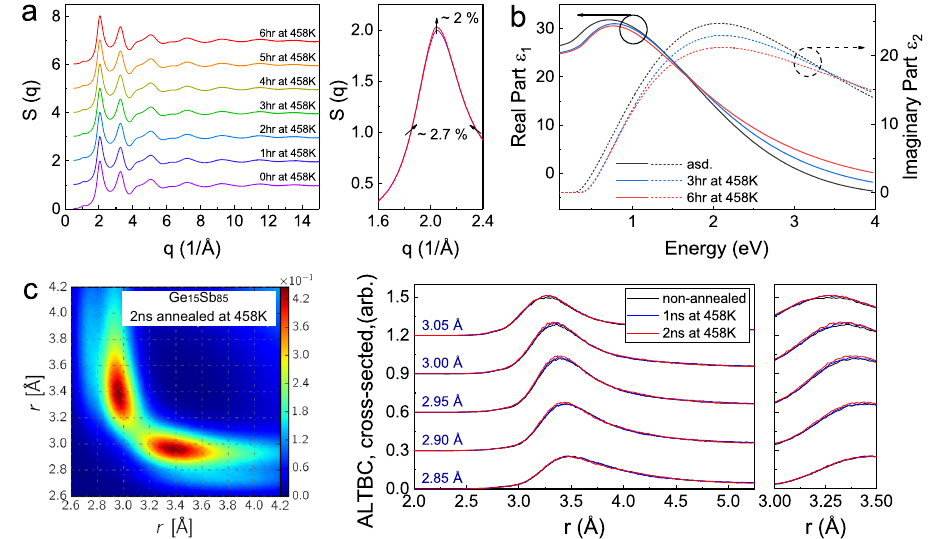
Fig.4|Thestructuralandbondingchangesduringtheisothermalannealingof the amorphous Ge 15 Sb 85 at ~458K. a The S(q) patterns during the isothermal annealing at ~458K for 6h. The spectra are vertically shifted for an easy view. The right panelshowsthe zoom-inofthe fi rst peak,where an increase in peakintensity and a narrowing of the full-width-half-maximum (FWHM) are observed upon annealing. Note only the 0h-annealed and 6hr-annealed curves are shown here. More S(q) data within the time interval and the difference Δ S(q) are shown in Sup- plementary Fig. 9 and the uncertainty analysis is given in the “ Methods ” section. b Dielectric functions for amorphous as-deposited and annealed (at ~458K)